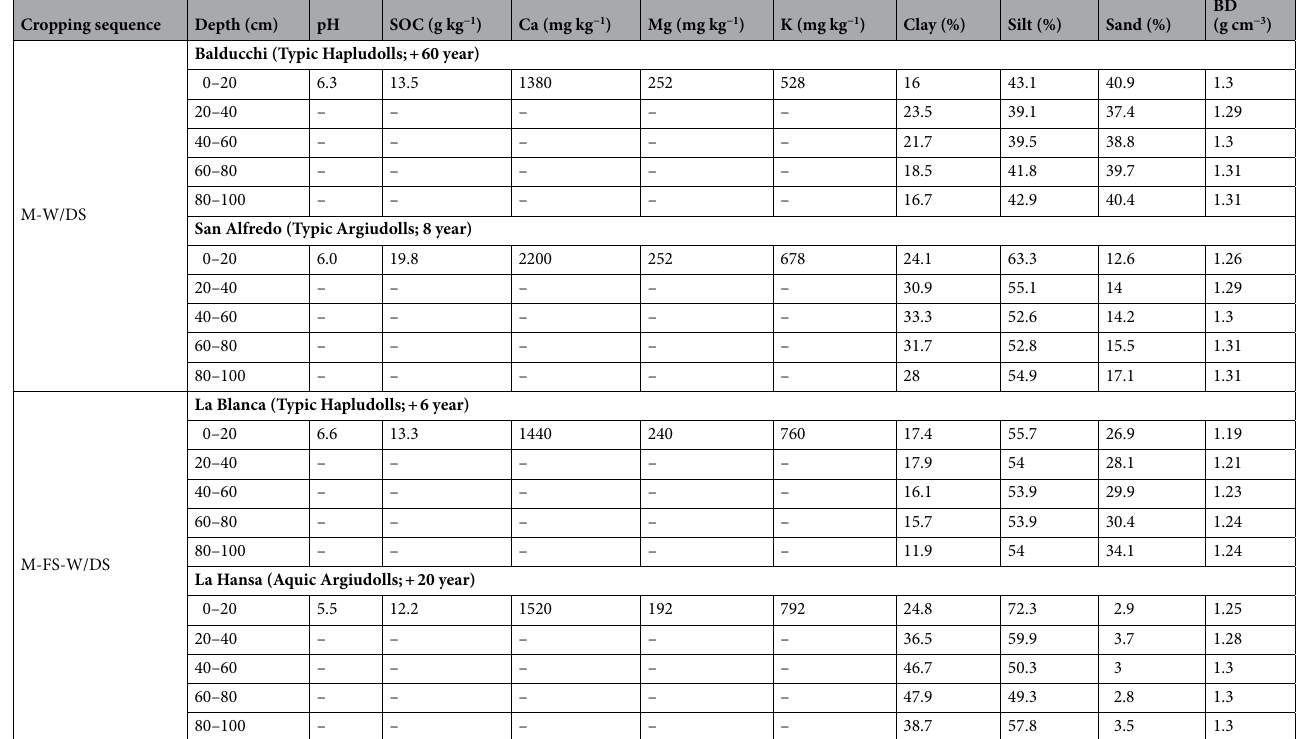
Table 1. Soil taxonomy, cropping history, and soil properties (0–20 cm and subsoil layers) at the onset of the experimentation term (September 2000) at four sites of the CREA Southern Santa Fe Crop Nutrition Network. Two sites were under maize–wheat/double-cropped soybean (M-W/DS) cropping sequence, and two under maize–full season soybean–wheat/double-cropped soybean (M-FS-W/DS). Each determination is the average of three replicates. SOC: soil organic carbon; BD: soil bulk density.